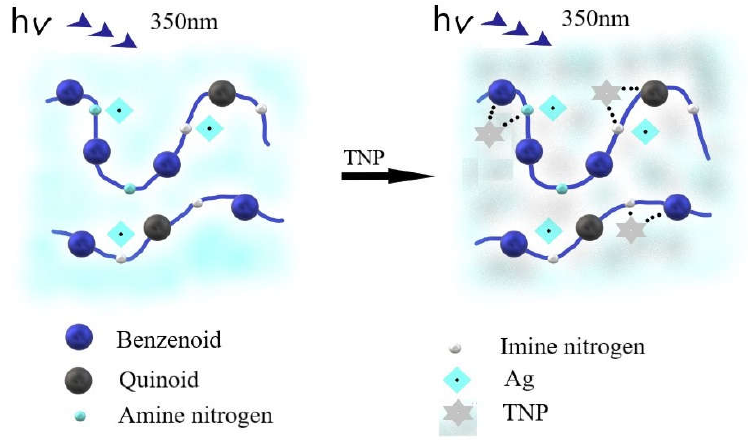
Figure 1. PANI-Ag composite and interaction of TNP with the PANI-Ag composite.